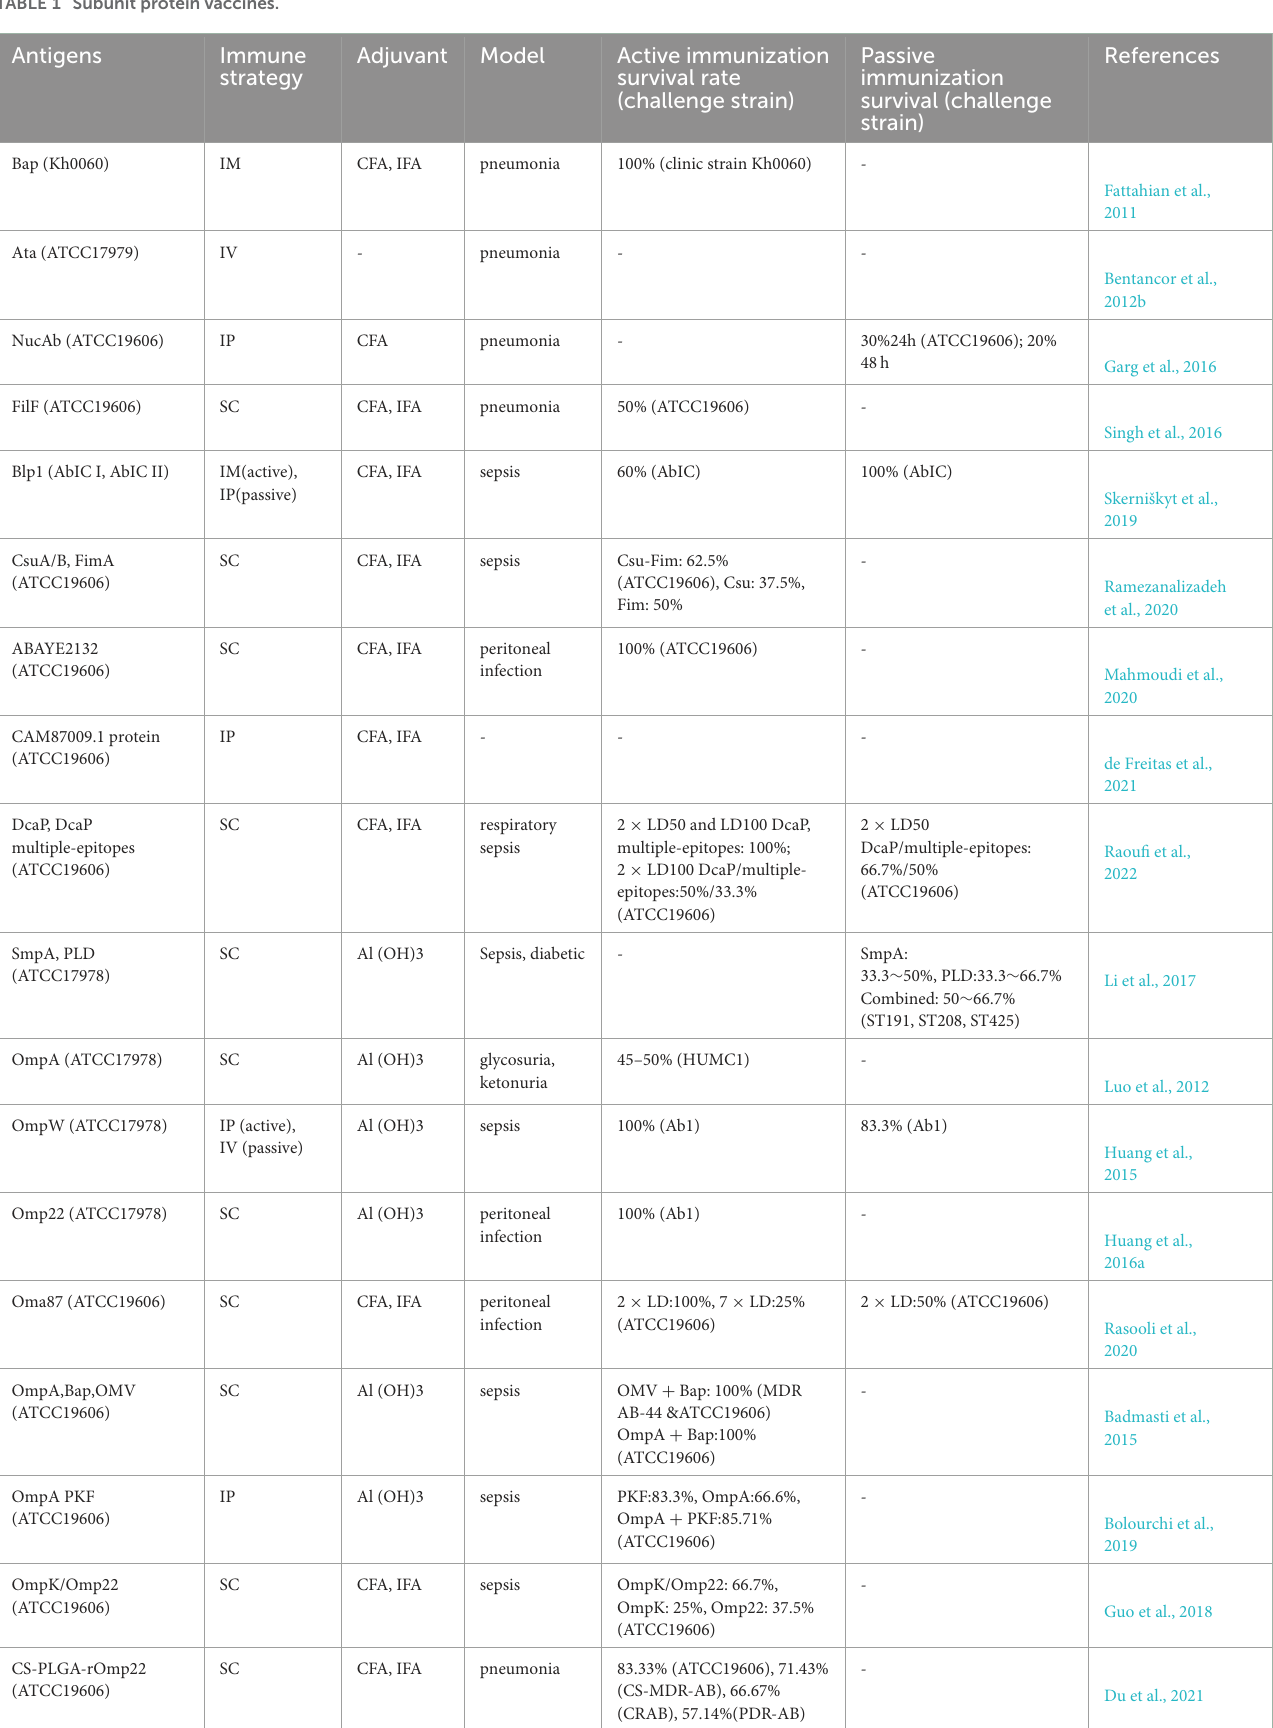
TABLE 1 Subunit protein